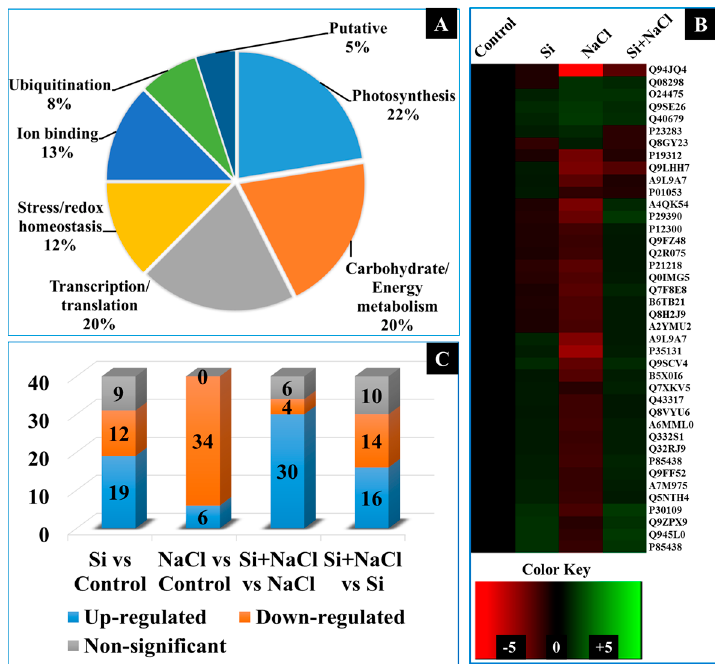
Figure 9. Comparative analysis of proteomic profiles between the treatments. Functional classification of identified proteins by Gene Ontology analysis ( A ), Heat map representation of differentially- expressed proteins ( B ), and the Venn diagram illustration of up-, down-, or non-significantly regulated proteins ( C ).